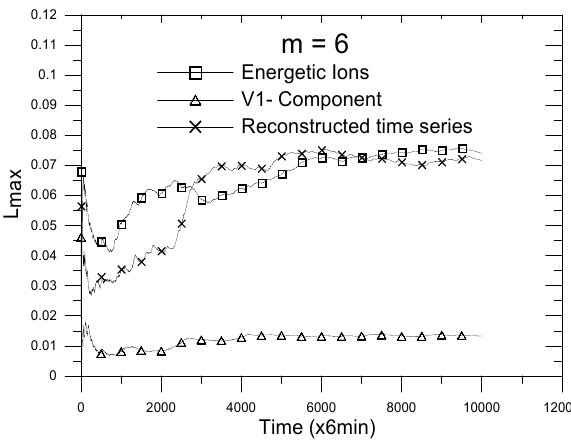
Figure 2 Fig. 2. The largest Lyapunov exponent L max as a function of the evolution time, for the energetic ions its reconstructed and its V 1 - component time